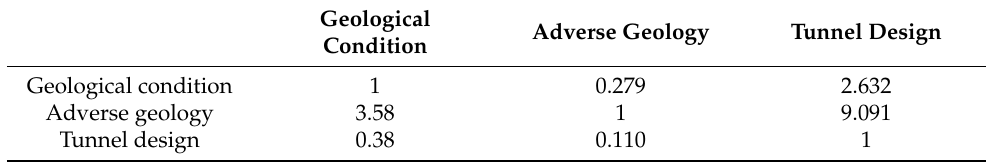
Table 10. Modified scoring table of objectives to criteria.